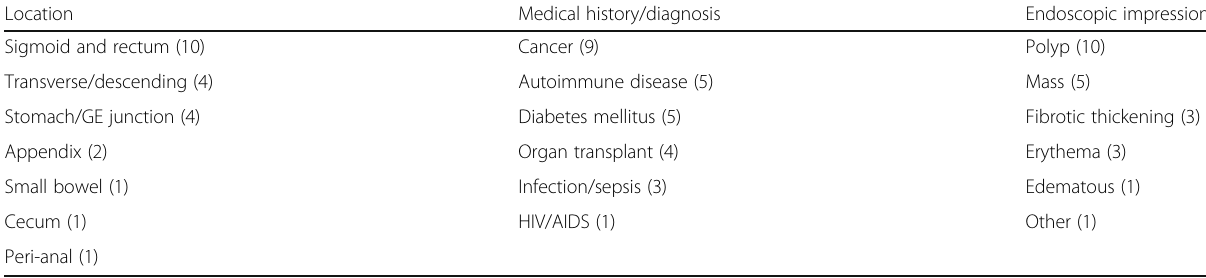
Table 1 Results for malakoplakia of the gastrointestinal tract based on location, diagnosis and endoscopic impression